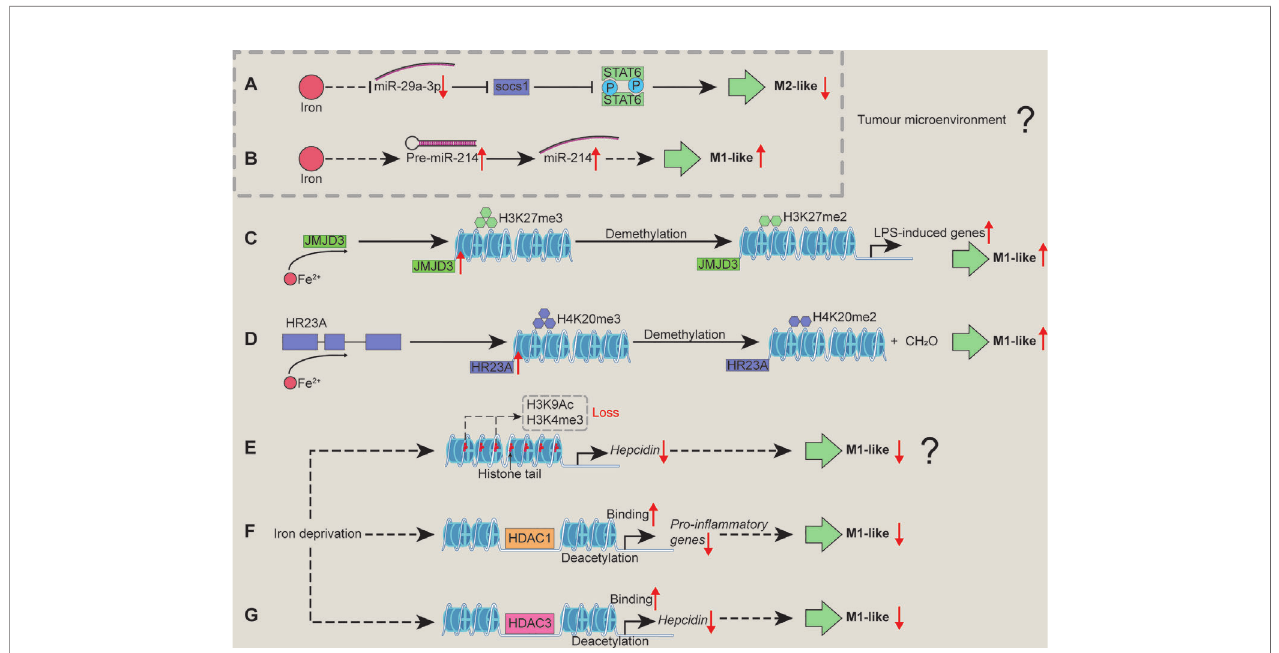
FIGURE 3 | Mechanisms associated with epigenetic regulation/modi fi cation whereby iron shapes macrophage polarization. Iron supplementation may reduce miR- 29a expression to block the activation of SOCS1/STAT6 signal pathway, inhibiting TAM polarization (A) . Iron could promote M1-like macrophage polarization by increasing miR-214 expression (B) . Iron could increase the enzyme activity of JMJD3 to demethylate H3K27me3, relieving the transcriptional silencing of LPS- induced genes and facilitating M1-like macrophage polarization (C) . Iron might promote macrophages toward pro-in fl ammatory phenotype through demethylating H4K20me3 by enhancing the enzyme activity of HR23A (D) . Iron de fi ciency might cause the loss of H3K9Ac and H3K4me3 to reduce hepcidin expression, inhibiting M1-like macrophage polarization (E) . Iron de fi ciency inhibits M1 activation (e.g., pro-in fl ammatory responses) possibly through increasing HDAC1 binding to the related genes (F) . Iron de fi ciency inhibits M1-like phenotype by lowering hepcidin expression via enhancing HDAC3 binds chromatin at the hepcidin locus (G) . H3K27me3, histone 3 lysine 27 trimethylation; H4K20me3, histone 4 lysine 20 trimethylation; HDAC, histone deacetylase; SOCS1, suppressor of cytokine